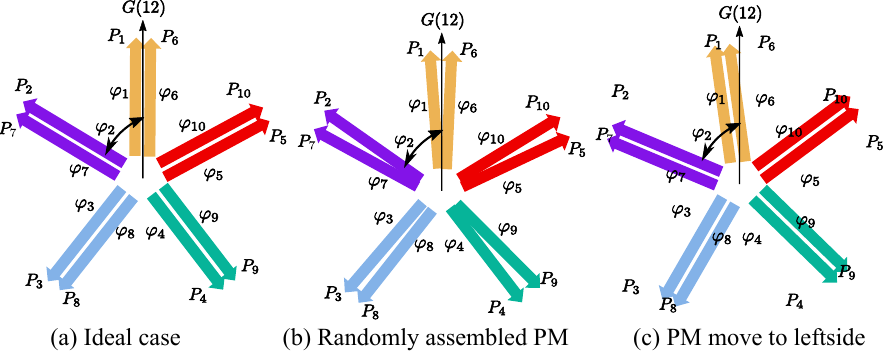
Figure 12. The vector diagram for G ( 12 ) considering the PM position uncertainties.